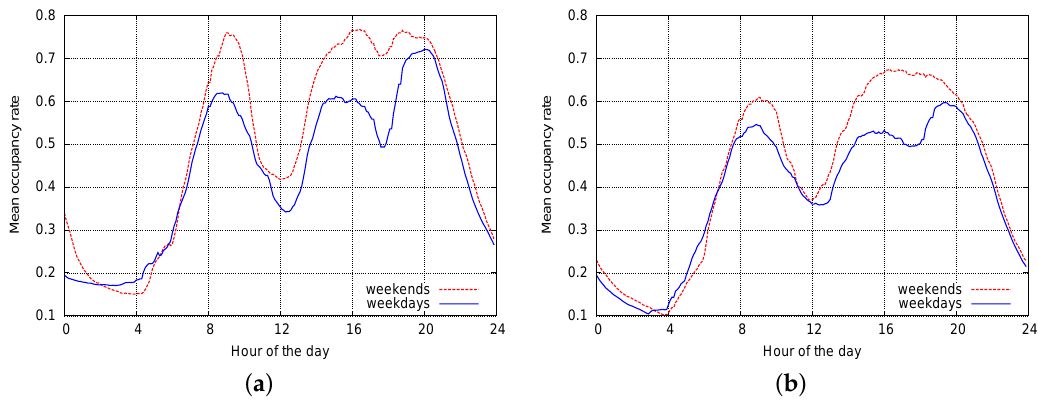
Figure 2. Holiday/weekend vs. weekday occupancy rates in the month of January 2015: comparison between occupancy rates from real data and synthetic traces generated by our event-based simulator. ( a ) Worldsensing dataset; ( b ) event-based